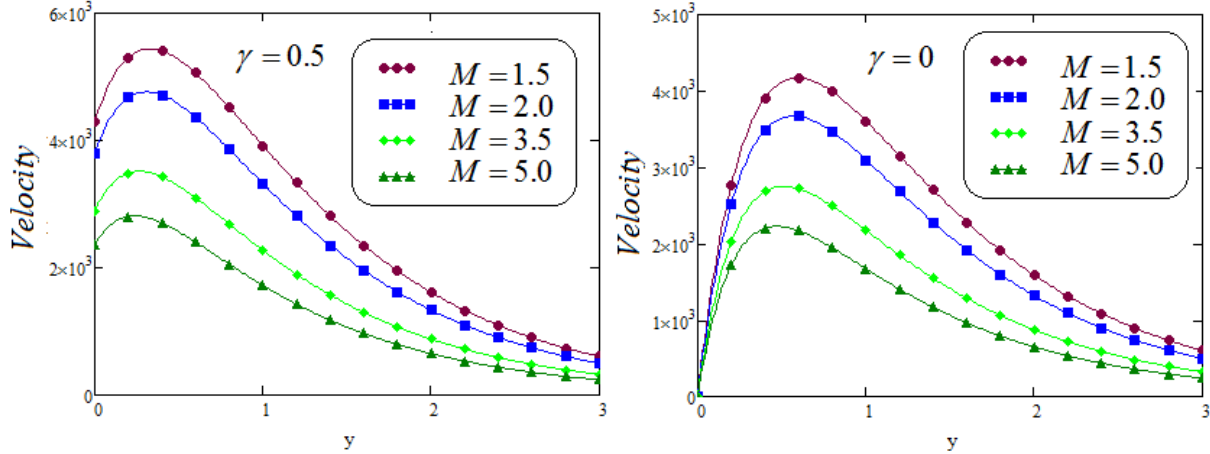
Figure 13. Velocity for varied values of M with and without slip effect γ when f ( t ) = sint , t = 1.5, α = 0.5, β = 0.3, Gr = 3.5, λ 1 = 0.6, λ 2 = 0.2, P r =